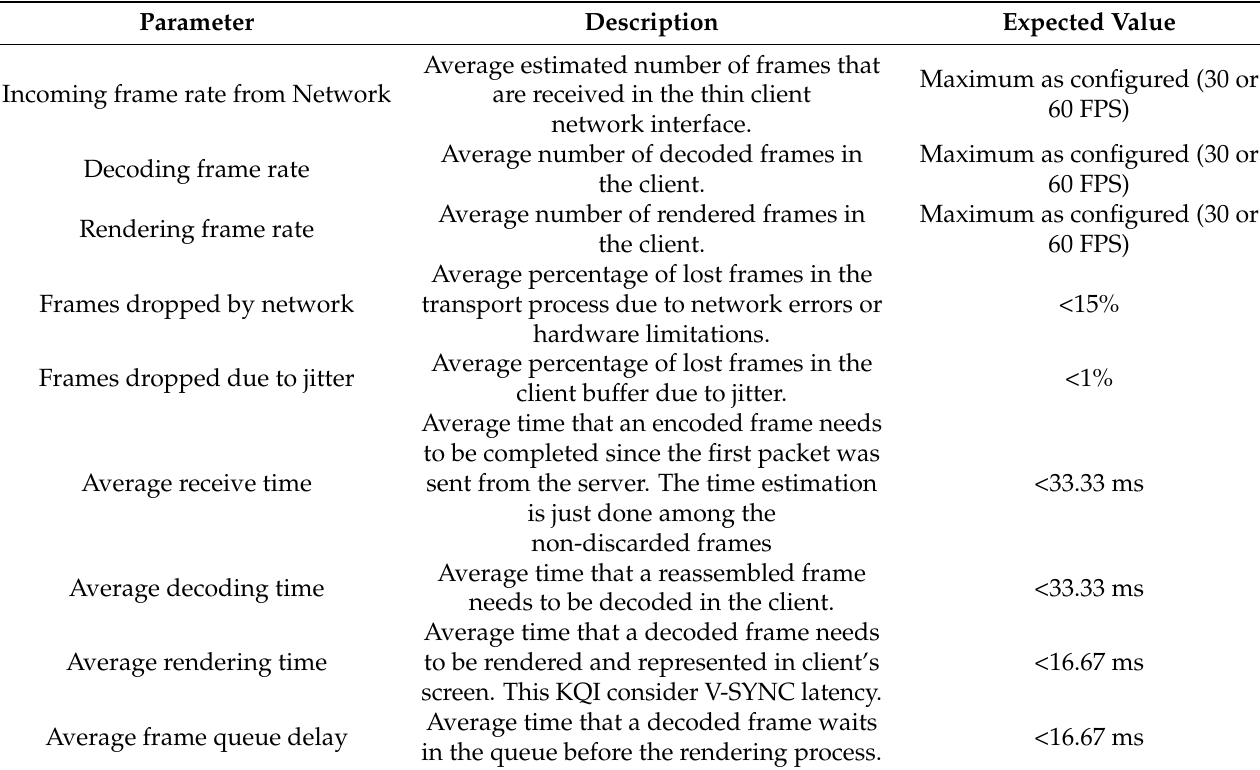
Table 2. Available Key Quality Indicators (KQIs) for each Cloud Gaming